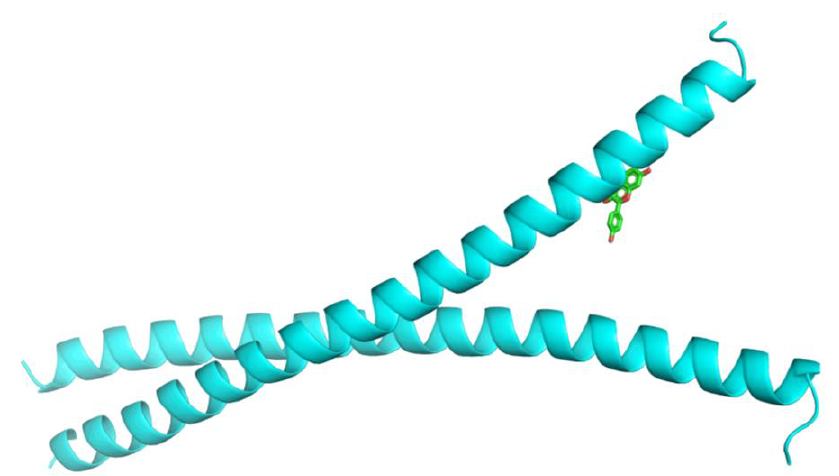
Figure 8. The docking diagram of JUN and quercetin.